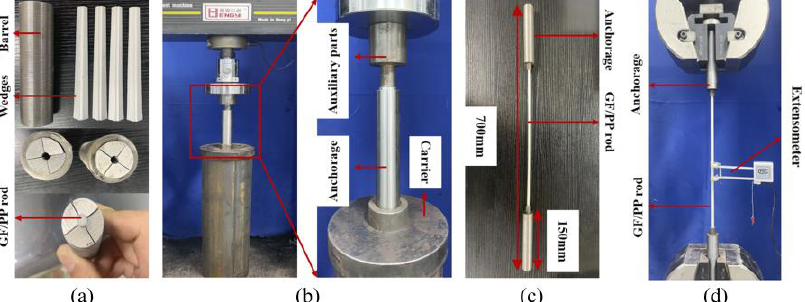
Figure 9. Mechanical test specimens machined from pultruded GF/PP flat laminates based on in- house-made PCTs: ( a ) tension test specimens; ( b ) flexure test specimens; ( c ) short-beam shear test specimens.